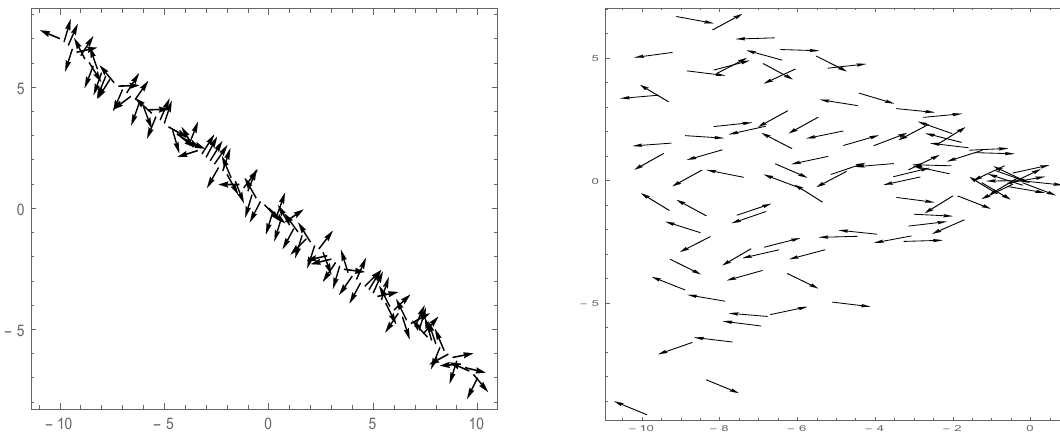
Figure 3 . Similar to figure 2. Left: the functional , (7.1), is represented as a vector field W supported on an ensemble of straight lines crossing the origin. Only one particular line is shown. − 1 , (7.2), is represented by a vector field supported on a plane. Right: the inverse functional W Here, only a cone with a limited slope is shown instead of the whole